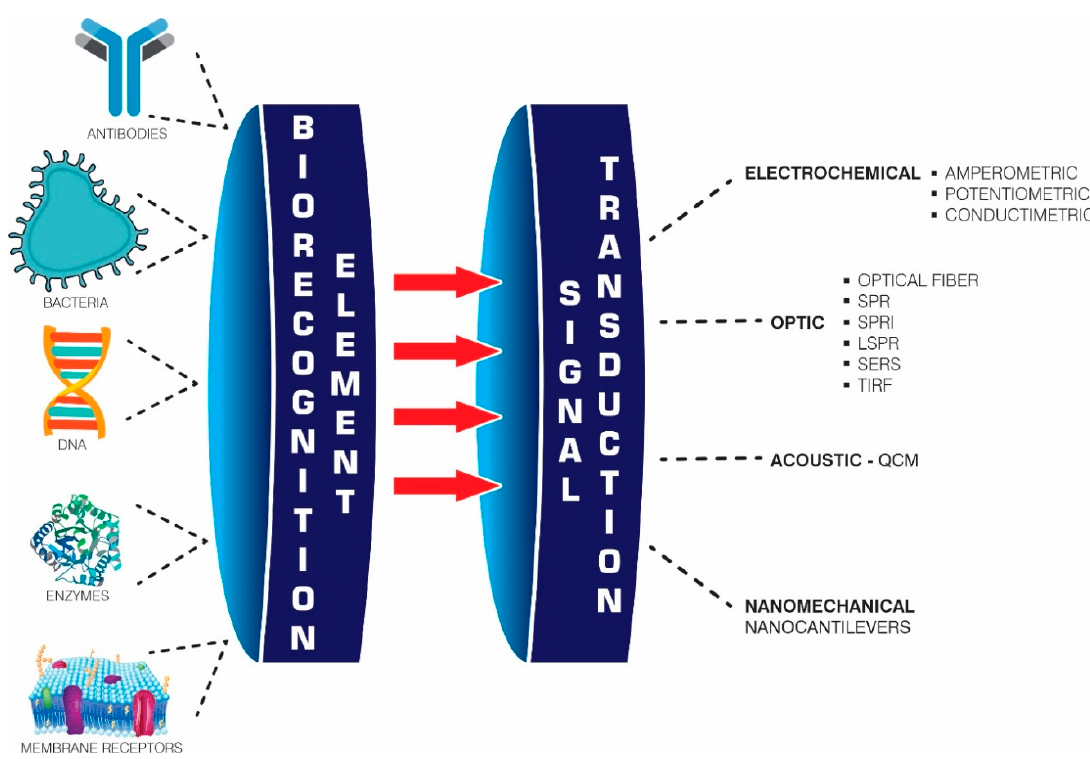
Figure 2. Scheme of a biosensor. Biosensors are made up of a biological recognition element and a method of signal transduction, and have allowed the quantification of various analytes.